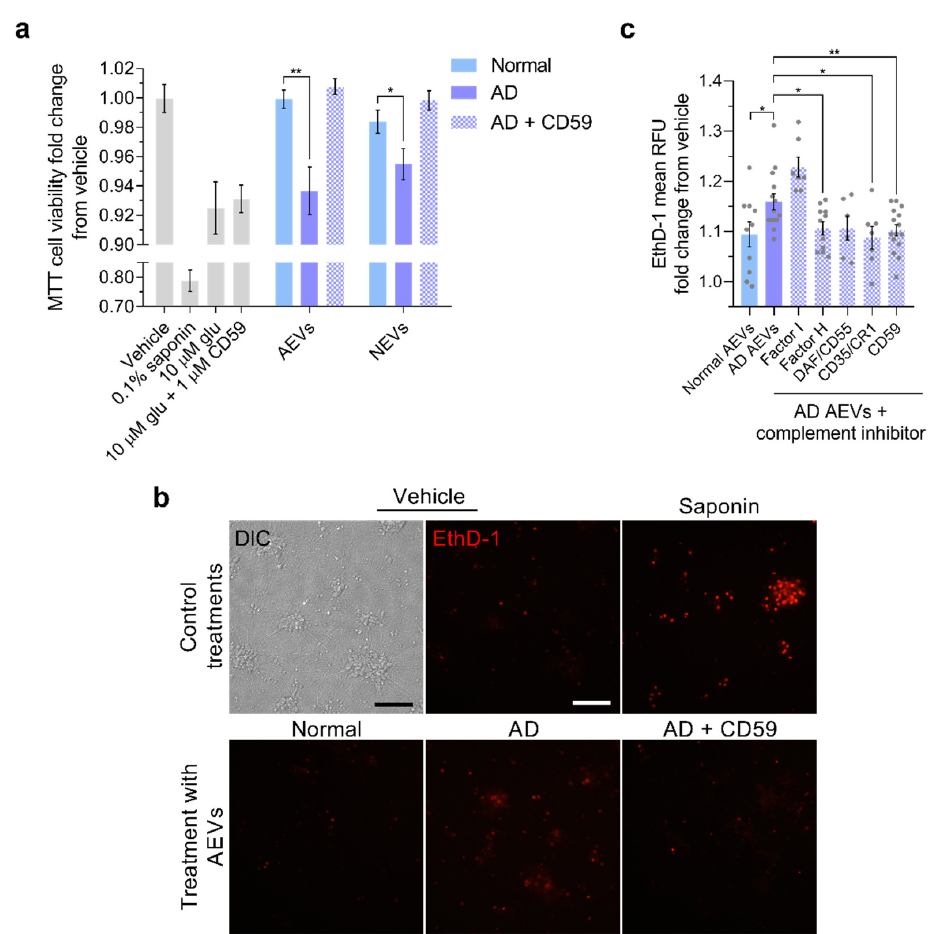
Figure 5. Complement inhibition prevents the neurotoxicity of AD AEVs and NEVs. ( a ) Bar graph showing significant decreases in MTT cell viability (fold-change from vehicle) observed in E18 rat cortical neurons treated with AEVs and NEVs from 4 AD participants, compared to neurons treated with AEVs and NEVs from the same 4 AD participants co-incubated with MAC inhibitor CD59 and compared to neurons treated with AEVs and NEVs from 4 normal controls; 600 EVs / neuron for 48 h were used. Neurons treated with 0.1% saponin detergent and 10 µ M glutamate were used as positive controls for neurotoxicity. Co-treatment of neurons with 10 µ M glutamate and 1 µ M CD59 shows that CD59 does not exacerbate the glutamate-mediated cell viability impairment nor does it rescue it. Each bar represents the mean value ± SEM obtained from the neurons treated in triplicate wells in two individual experiments. For NEVs, AD vs. Normal, p = 0.013; AD plus CD59 vs. Normal, p = 0.859; AD vs. AD plus CD59, p = 0.113. For AEVs, AD vs. Normal, p = 0.001; AD plus CD59 vs. Normal, p = 0.609; AD vs. AD plus CD59, p = 0.016. ( b ) Human iPSC-derived neurons incubated with AD AEVs at 800 EVs / mL for 48 h showed an increased nuclear EthD-1 fluorescence, in comparison with neurons treated with AEVs from normal controls and vehicle-treated cells. Co-incubation with CD59 blocks the AD AEV-mediated EthD-1 fluorescence increase. Neurons treated with 0.1% saponin detergent were used as a positive control of neurotoxicity. Scale bar, 200 µ m. ( c ) Bar graph with individual values in grey showing the EthD-1 mean relative fluorescence units (RFU) fold-change over vehicle ± SEM from human iPSC-derived neurons treated with AEVs from 5 AD participants, with or without the indicated complement inhibitors and 5 normal controls in duplicates or triplicates. * p < 0.05, ** p < 0.01, ***** p < 0.0001.